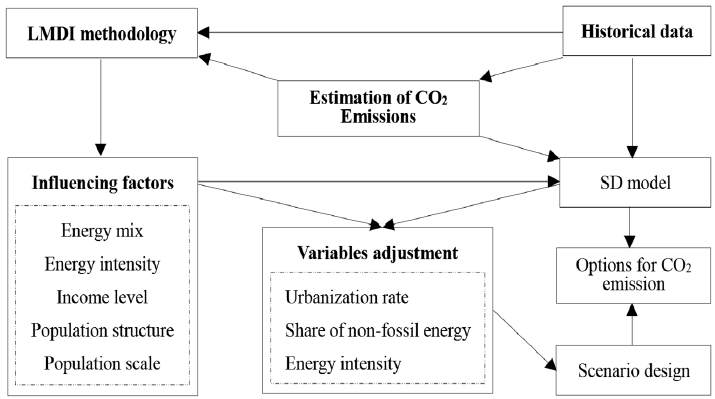
Figure 1. Model structure overview.